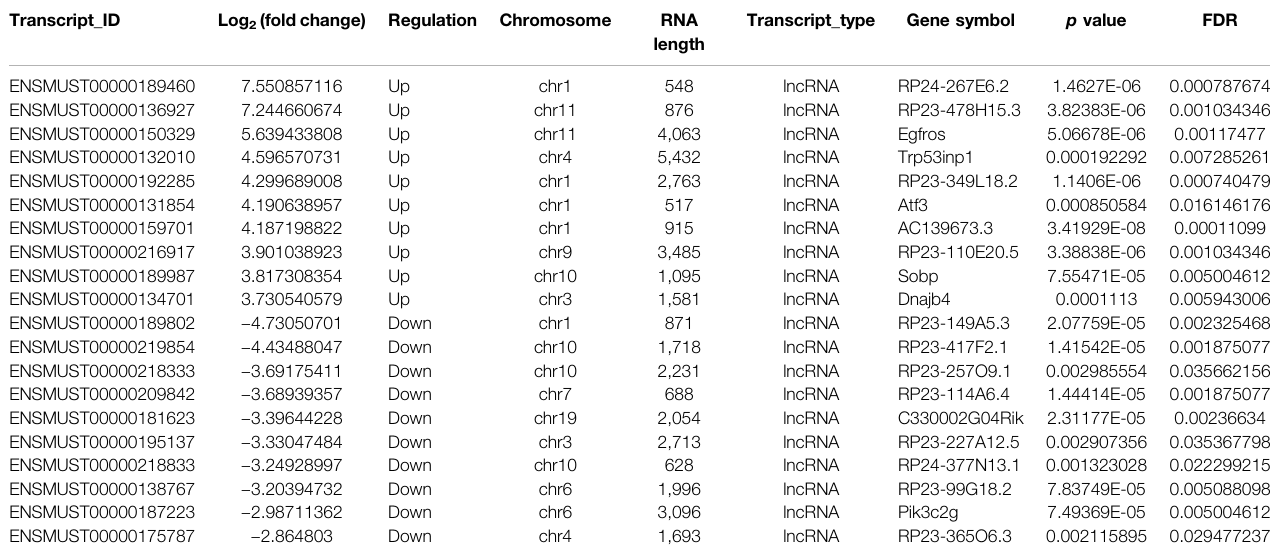
TABLE 3 | Top 20 differently methylated lncRNAs in the kidneys after cisplatin treatment. Log 2 (foldchange) Regulation